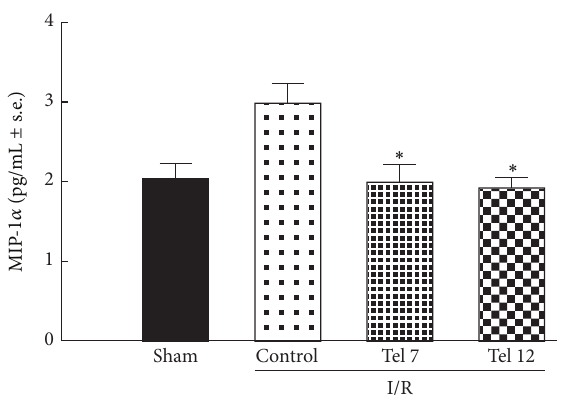
Figure 6: Telmisartan reduces cardiac macrophage inflammatory protein-1 alpha (MIP-1 𝛼 ) content in infarcted ZDF rats. Values are reported as means ± s . e. ∗ 𝑃 < 0.05 versus control. I/R (ische- mia/reperfusion); tel 7 (telmisartan 7 mg/kg); tel 12 (telmisartan